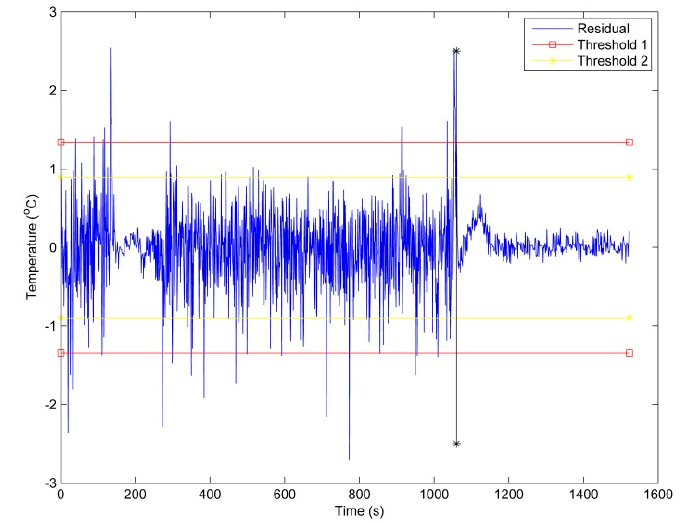
Figure 10. Residual control diagram of an abnormal operating gearbox tank.